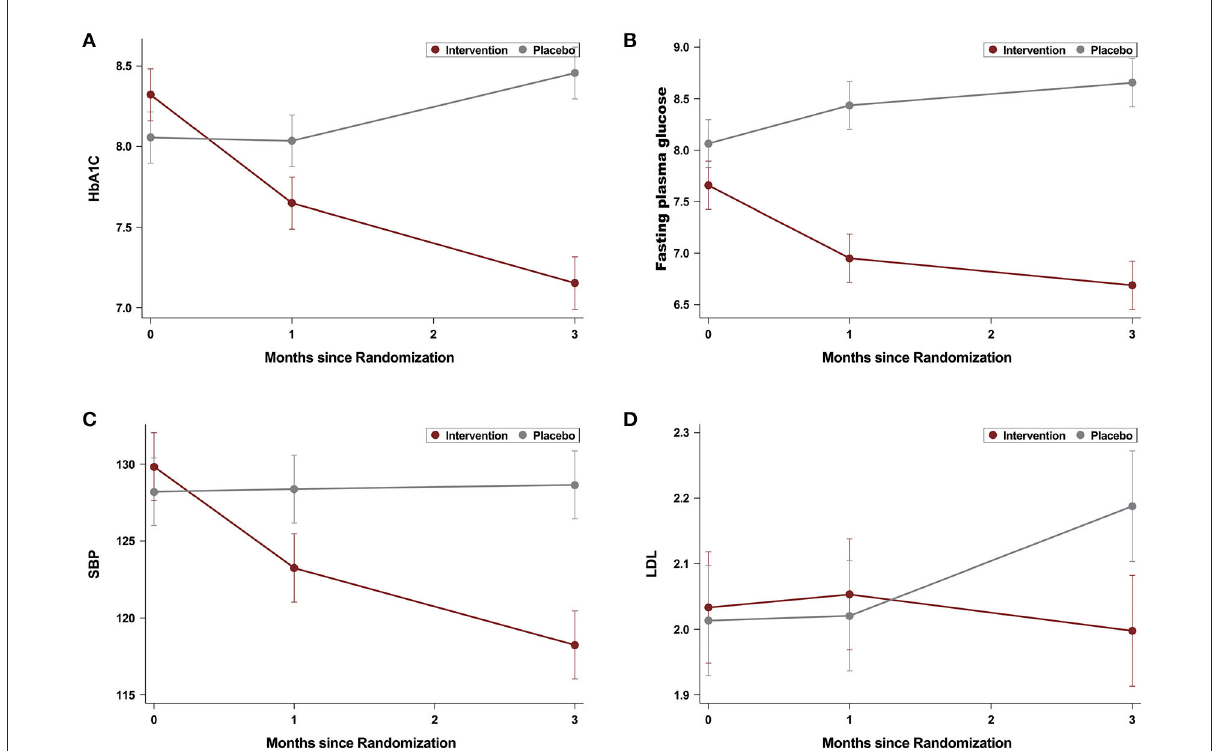
FIGURE2 Changes in hemoglobin A1C (HbA1C) (A) , fasting blood glucose (FBG) (B) , systolic blood pressure (SBP) (C) , and low-density lipoprotein (LDL) (D) levels during 3 months of follow-up.